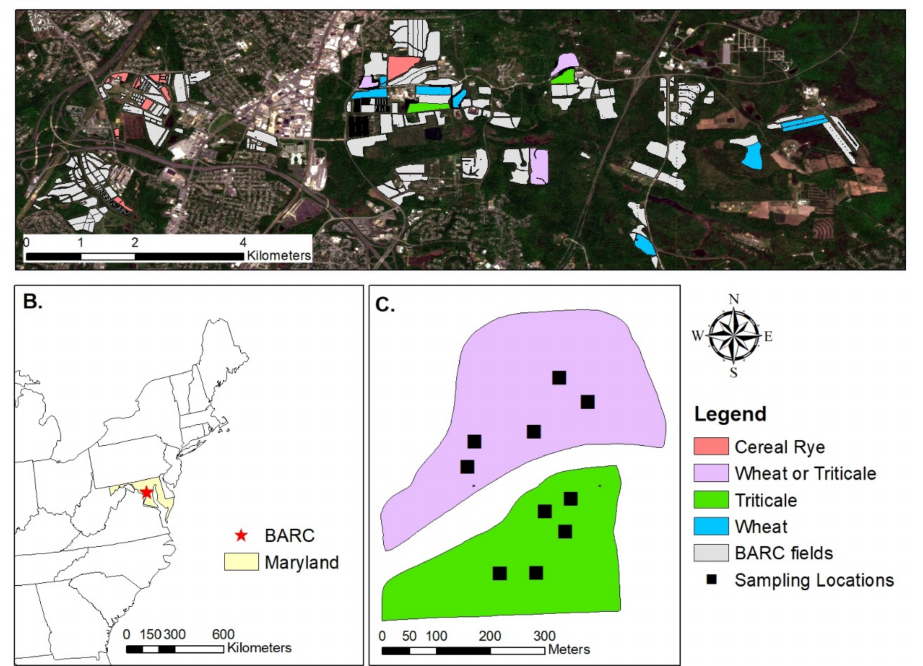
Figure 1. Overview of the study area located at the Beltsville Agricultural Research Center (BARC) in Maryland ( A , B ). Study fields (2019–2021) are colored by species. Some fields (purple) were used by wheat and triticale in different years of the study. Approximately five flagged locations were sampled within each field at a given sampling time or event ( C ). ( A ) contains a Sentinel-2 satellite image from 1 May 2020; ( B ) uses a map of the United States, courtesy of the Federal